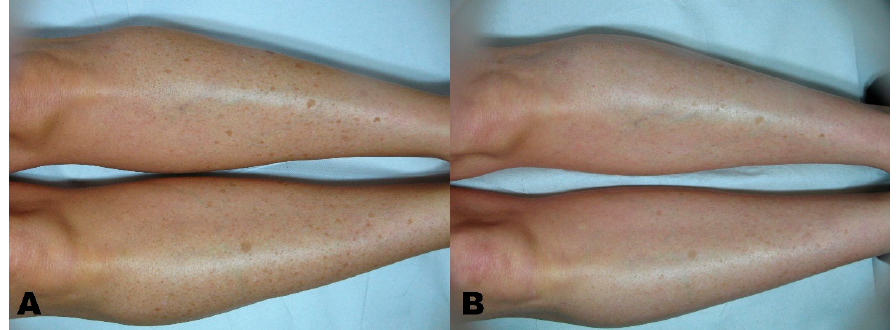
Figure 4. ( A ) Hypermelanosis before treatment. ( B ) region three months after the last session.